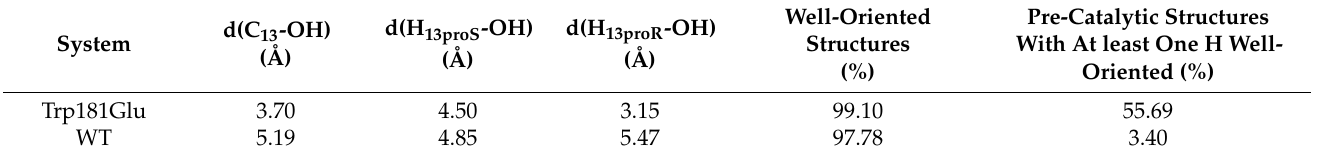
Table 2. Average distances of C 13 (d(C 13 -OH)) and its hydrogen atoms H 13proS (d(H 13proS -OH)) and H 13proR (d(H 13proR -OH)) of AA to the iron-bound OH-group for the Trp181Glu-ALOX15-AA and WT-ALOX15-AA complexes 1 .